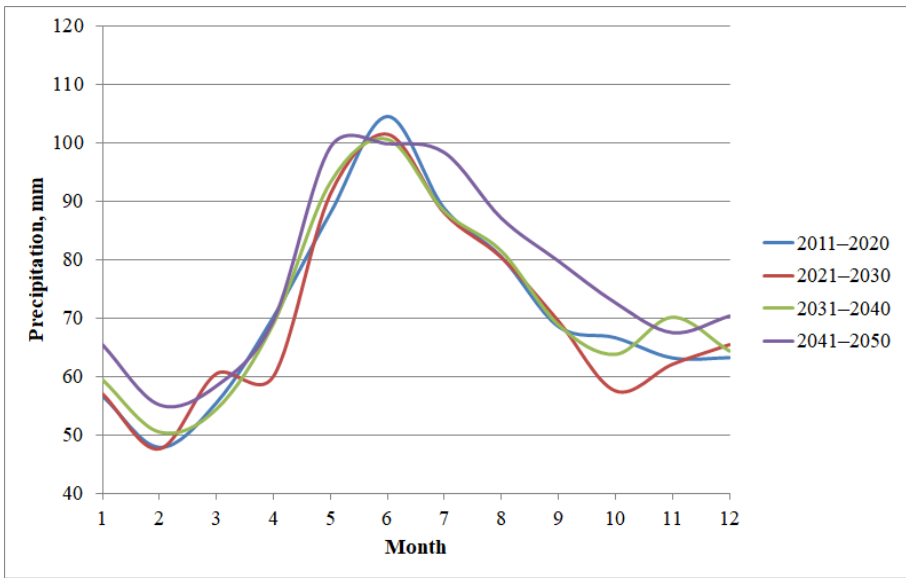
Figure 5. Average monthly amount of precipitation by decade in the Janina mine waste dump region (Chrzanowski county, Poland).